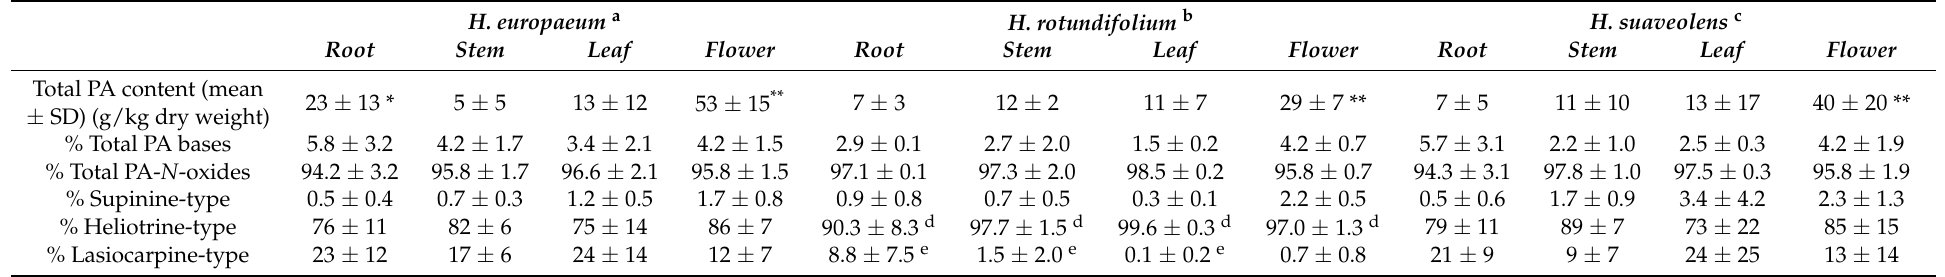
Table 1. PA content of the major plant parts of H. europaeum , H. rotundifolium and H. suaveolens . The PAs were classified according to the PA necine base and the number and type of esterifying necic acids.